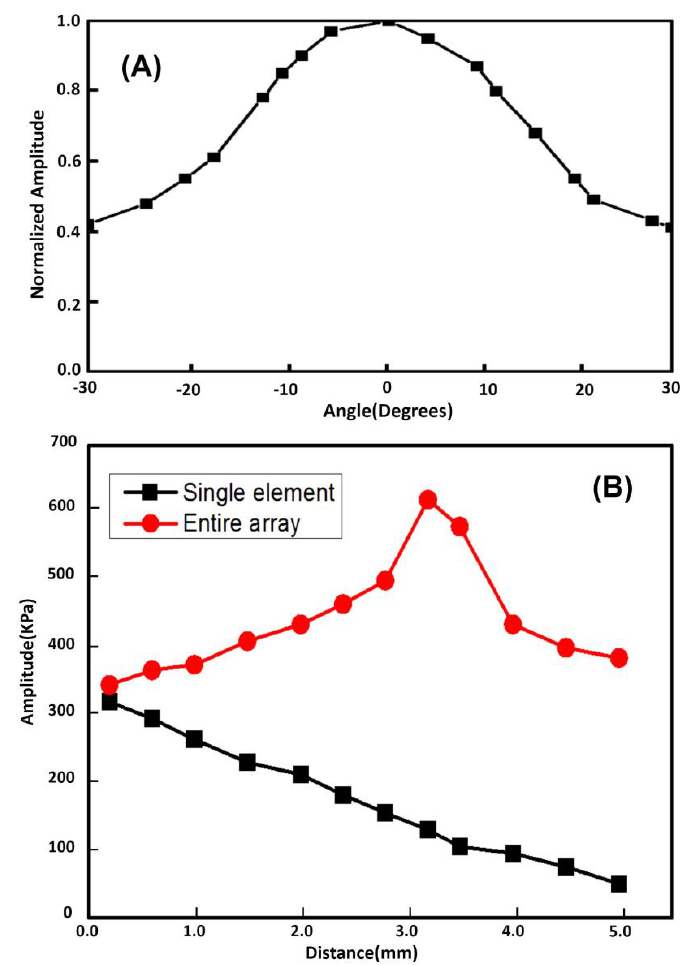
Figure 6. ( A ) Measured one-way azimuthal directivity responses of a representative array element (24th element). ( B ) The acoustic output in the axial direction of a representative array element (24th element) and the entire array.